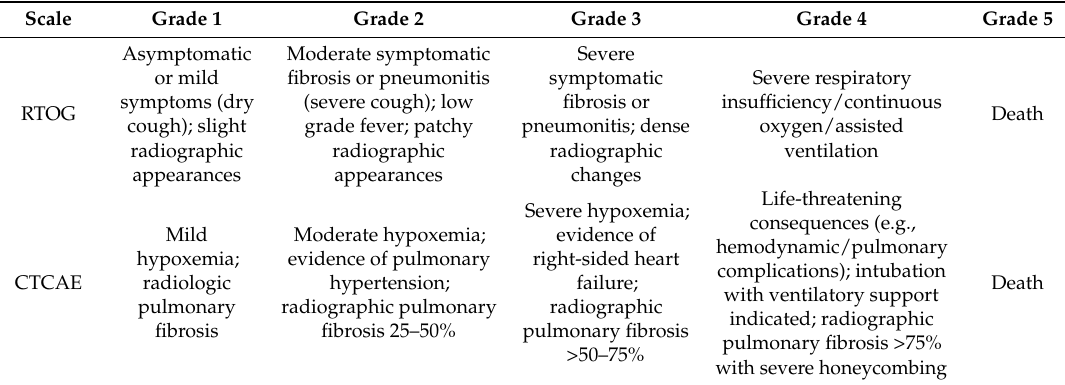
Table 3. Commonly-utilized pulmonary fibrosis grading